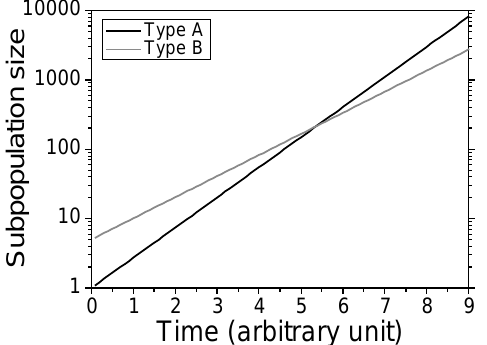
Figure 4. The subpopulation size of two exponentially-growing populations (A: black, B: gray). Subpopulation A has a lower initial population size, N A,0 = 1, but a higher growth rate ( r A = 1), whereas subpopulation B has a higher initial population size, N B,0 = 5 and a lower growth rate ( r B = 0.7 ). The population size of subpopulation A overcomes that of subpopulation B, but initially it has a lower population